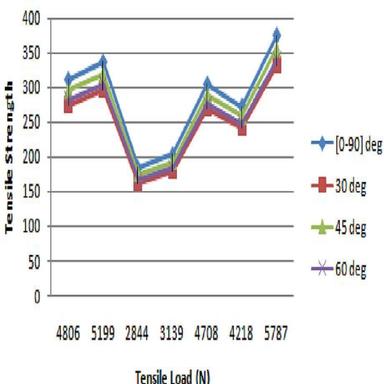
Tensile Strength of C–C laminate for various fiber angles.